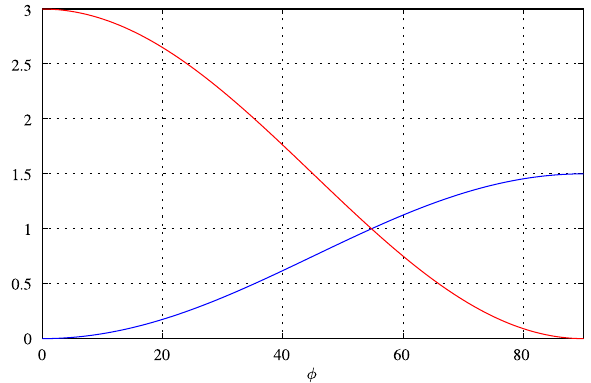
Figure 2. Plot of N sin 2 φ (blue) and N cos 2 φ (red) for N = 2